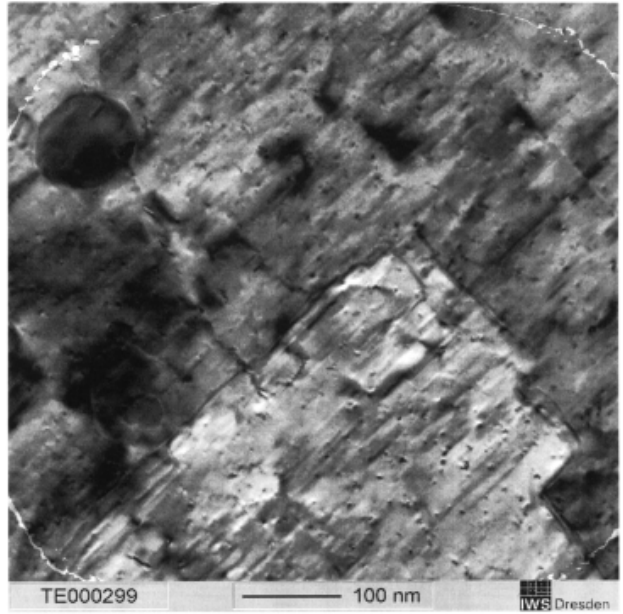
Figure 2. TEM results for the AlMgSi1 alloy in the initial state. Precipitation strengthening in the crystal state.